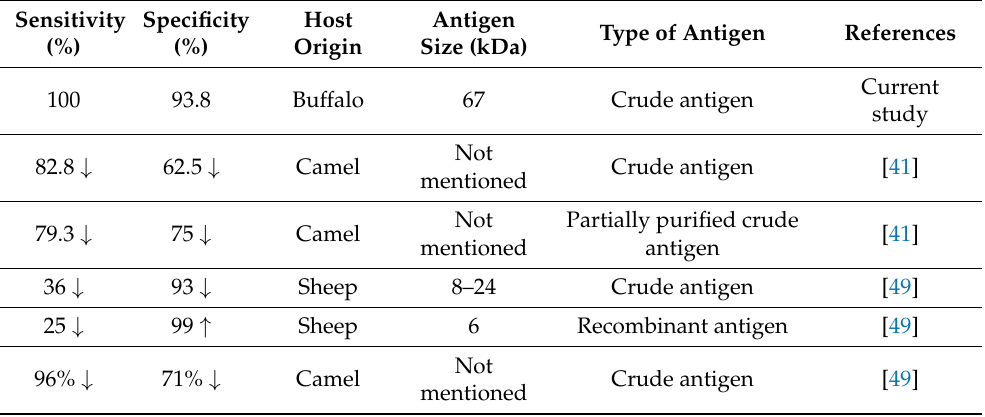
Table 5. Comparison of sensitivity and specificity of iEgELISA based on crude antigen (this study) with results from previous work. Arrows denote the direction of change compared with values from the present